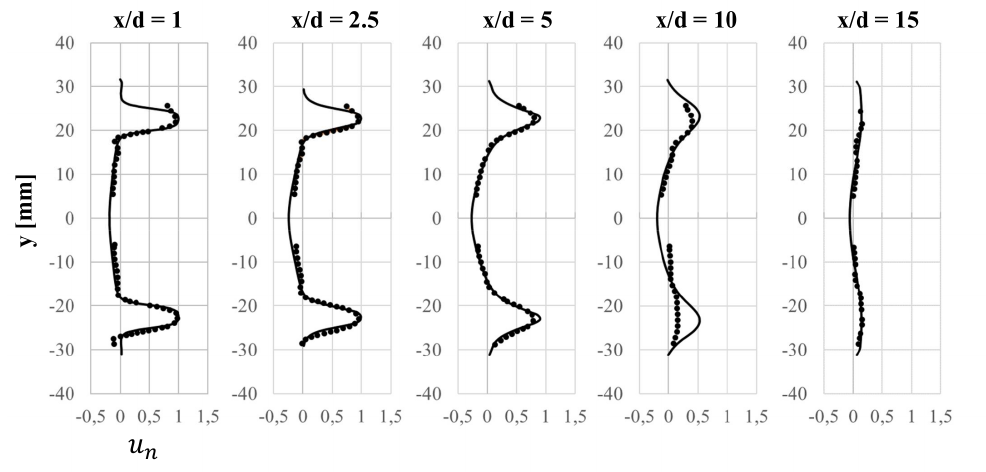
Figure 6. Comparison of PIV (dots) [42] and CFD (lines) axial velocities at different heights x / d above the burner nozzles. Normalized velocities.